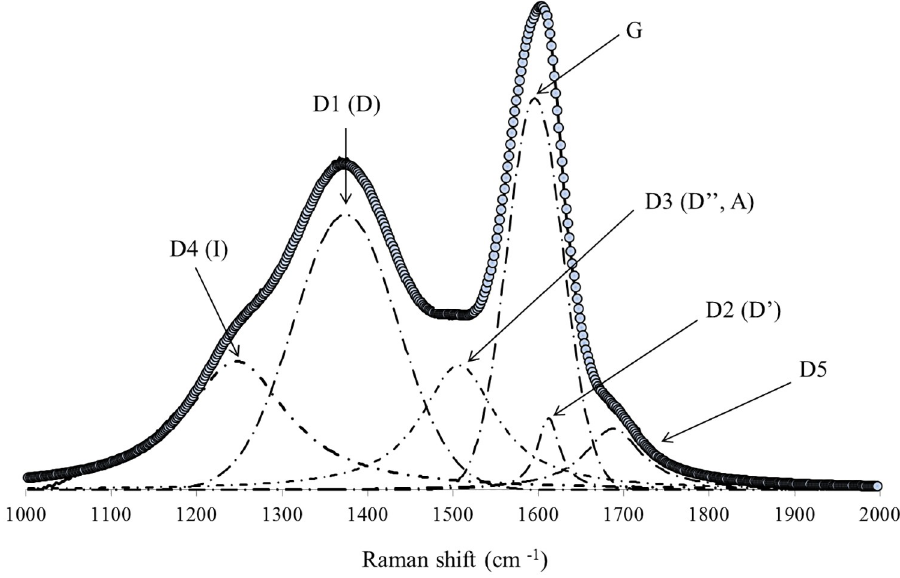
Fig 2. Example of the fitting performed in the samples used in this